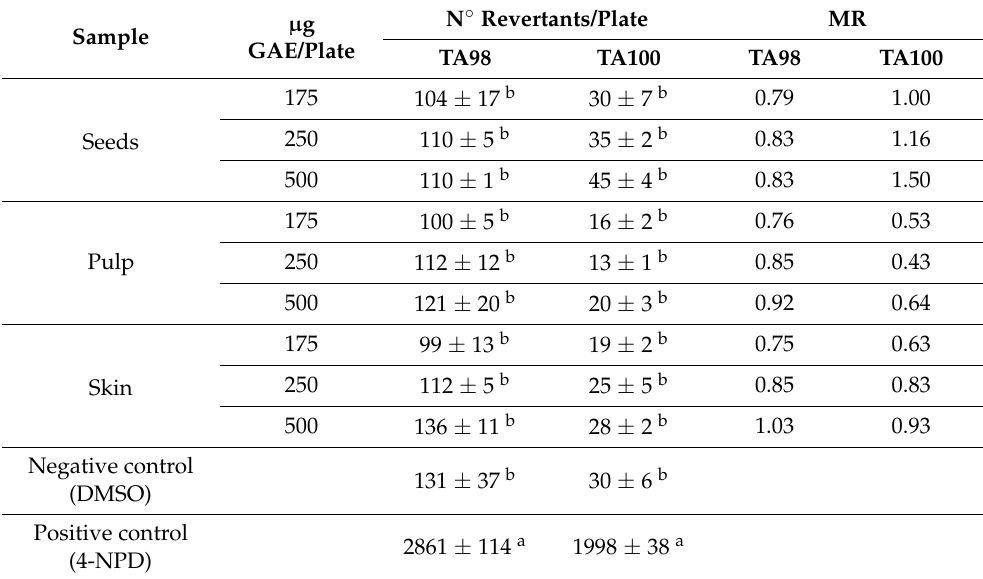
Table 2. Mutagenic activity of extracts (PEE) of the three parts of the Z. mistol fruit assayed in Salmonella